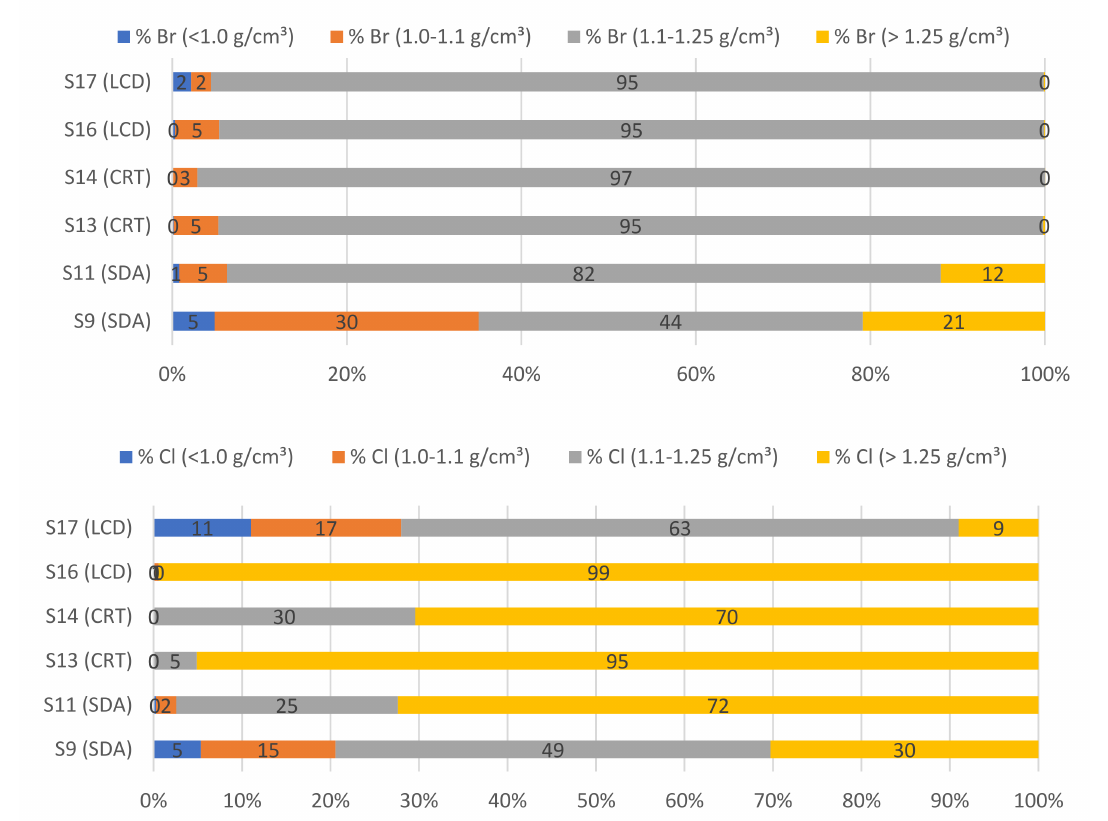
Figure 3. Bromine (above) and chlorine (below) freights continued in the 4 density fractions of untreated WEEE samples from SDA, ICT, CRT and flat screens.